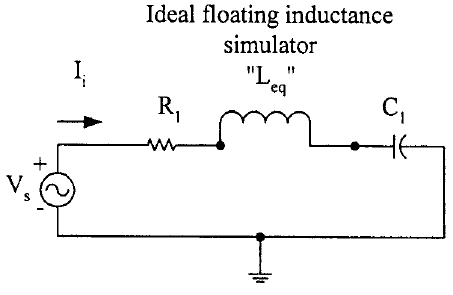
FIGURE 2 Prototype passive circuit for a